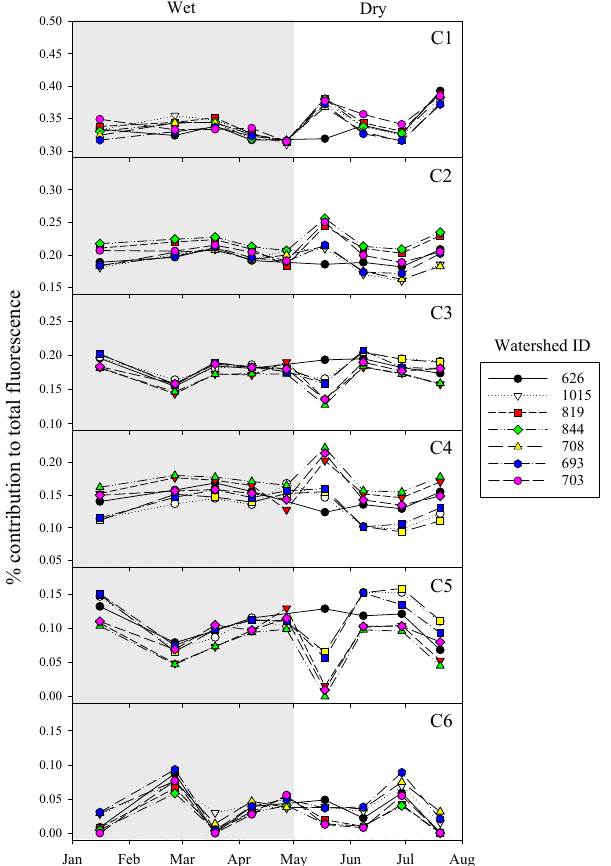
Figure 6. Percent contribution of the six components identified in parallel factor analysis (PARAFAC) for samples collected every three weeks from January–July 2016 from the seven study water- sheds on Calvert and Hecate islands. The grey shading indicates the wet period and the unshaded region indicates the dry period. Note that while the y axis for each panel has a range of 20%, the max and min for each y axis varies by